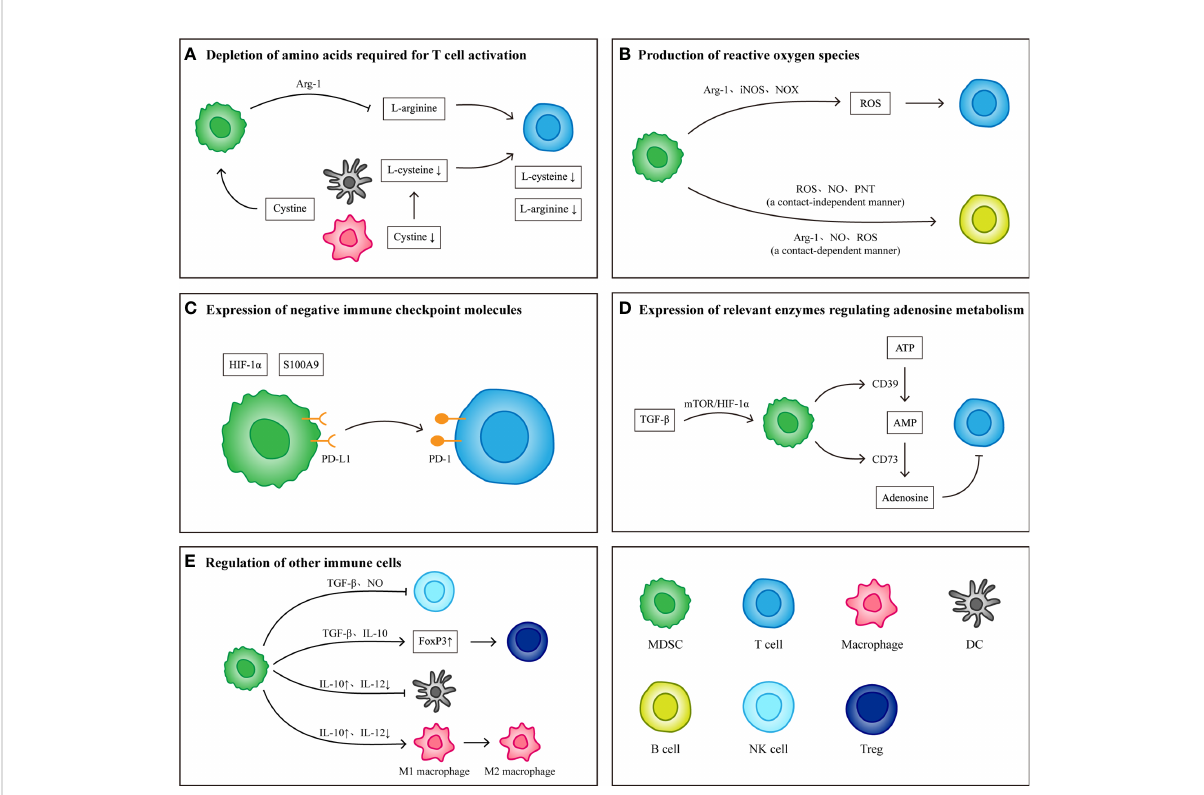
FIGURE 2 Immunological effects of MDSCs. (A) MDSCs consume L-arginine and L-cysteine required for T cell activation by expressing Arg-1 and ingesting cystine. (B) MDSCs produce reactive oxygen species by expressing Arg-1, iNOS and NOX. Different components of reactive oxygen species have inhibitory effects on T cells and B cells. (C) Under the induction of S100A9 and HIF-1 a , the expression levels of PD-L1 on MDSCs increased. High levels of PD-L1 combined with PD-1 on T cells induced T cell apoptosis. (D) TGF- b Induce MDSCs to produce CD39 and CD73, which can induce the conversion of ATP to adenosine. The presence of adenosine inhibits the activation and proliferation of T cells. (E) In addition to inhibiting T cells, MDSCs can also regulate other immune cells to protect tumor cells and establish immune microenvironment. MDSCs inhibit the killing effect of NK cells by producing TGF- b and NO) they weakened the antigen-presenting function of DCs and macrophages by producing IL-10, and transformed M1 macrophages into M2 macrophages) they also secrete TGF- b and IL-10 up regulates the expression of FoxP3 in Tregs and induce the production of FoxP3 +